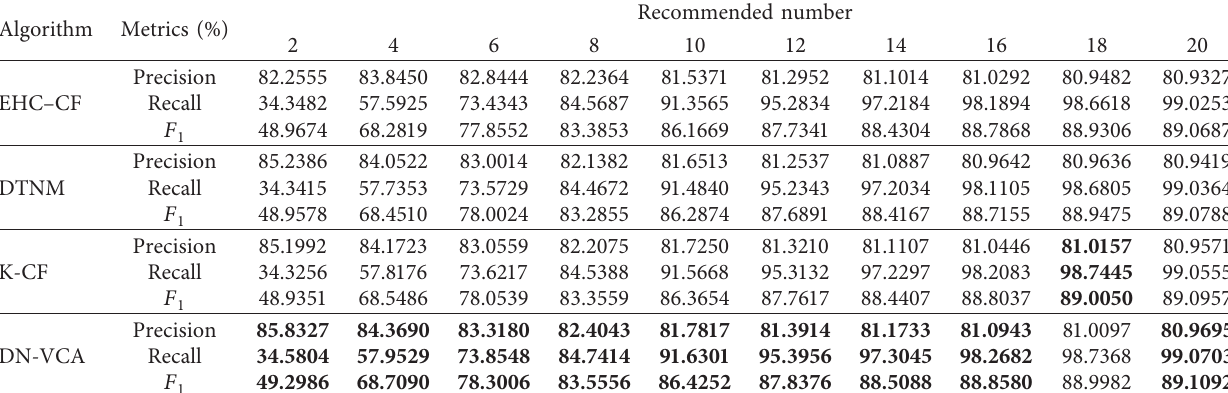
of EHC − CF, DTNM, K − CF, and DN − VCA based on FilmTrust-1 dataset. 1